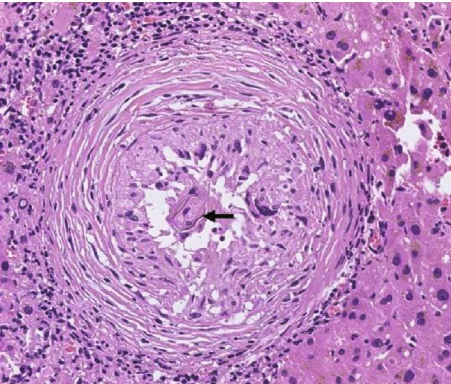
Figure 2: Microscopic image of gallbladder wall showing Schistosoma parasite within noncaseating granuloma (magni fi cation HE ×